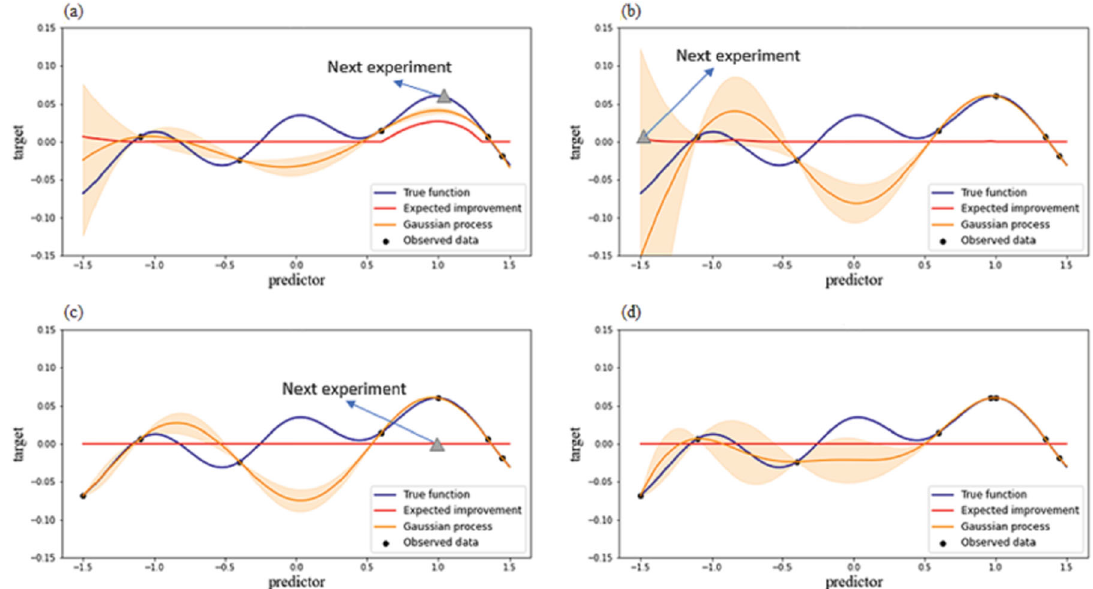
Fig. 4 Schematic illustration of Bayesian optimization (BO). Four subplots ( a – d ) give an example of the sequential automated experimental design using BO. They describe the true unknown function (blue curve), expected improvement (red curve), fi tted values using GP (orange curve), 95% con fi dence interval (orange shaded area), observed samples (black points), and the next experiment recommended by the utility/ acquisition function (gray triangle).